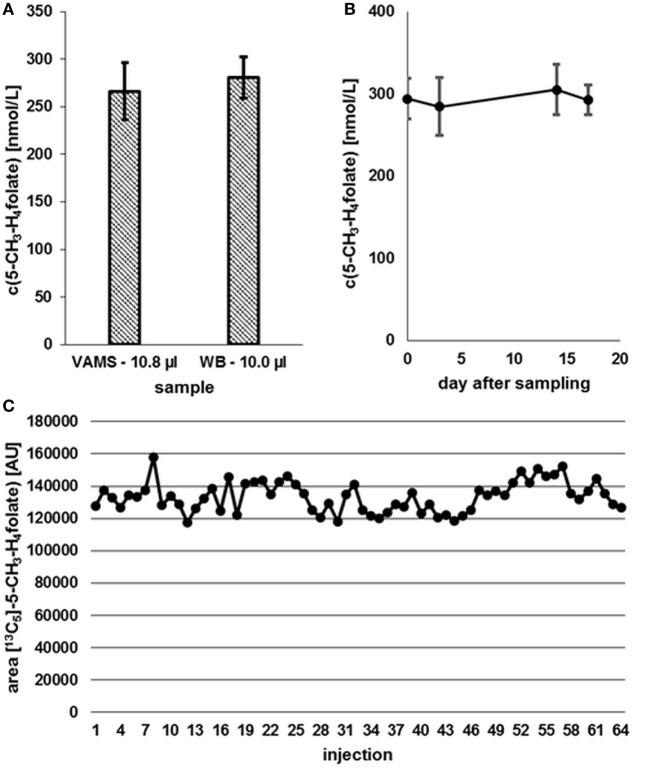
(A) Effect of the drying process (2.5 h) on analyte stability in volumetric absorptive microsamplers (VAMS) compared to a whole blood (WB) sample. (B) Stability at −20°C. (C) Stability in extracted samples during LC-MS/MS analysis. Finger blood from one blood donor analyzed as VAMS containing 10.8 μL of dried WB: freshly drawn WB after forefinger punction. Peak areas of [13C5]-5-CH3-H4folate obtained from multiple injections of blood sample extracts to which the same amount of [13C5]-5-CH3-H4folate has been added. (A,B) Mean ± SD (n = 3).